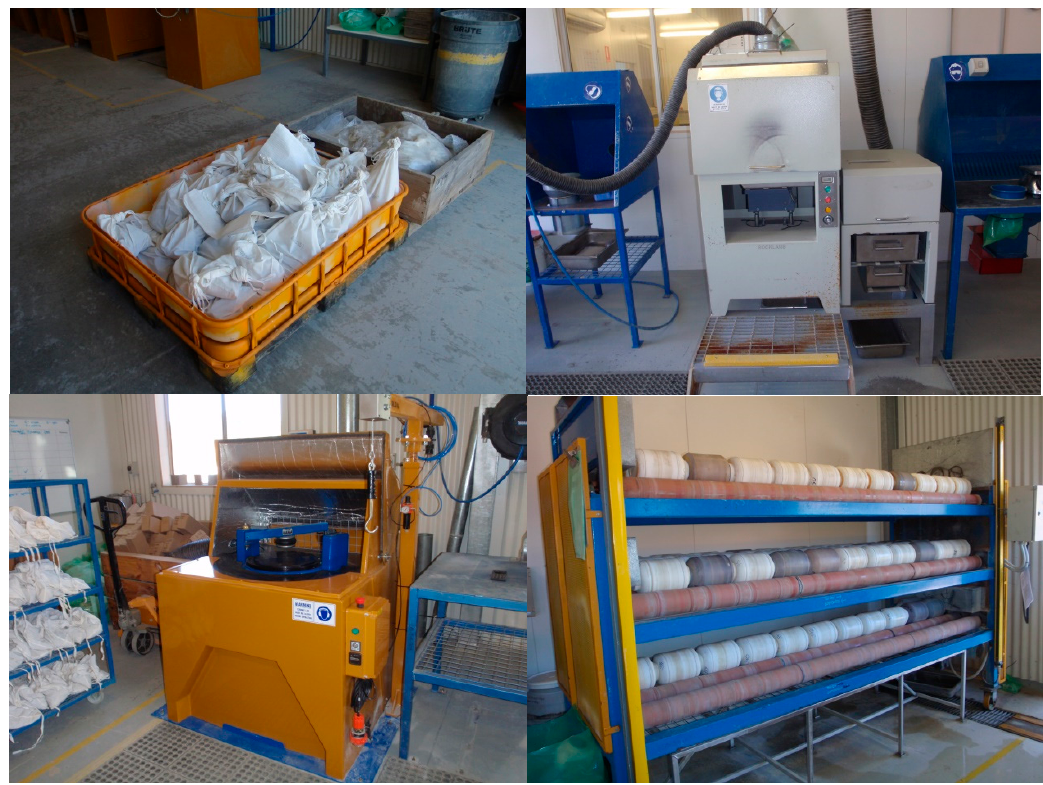
Figure 4. Current on-site laboratory—Clockwise: received samples; Boyd crusher and rotary splitter; LM5 pulveriser; and LeachWELL bottle roll unit.